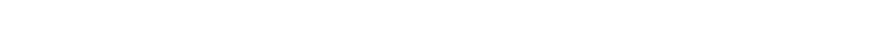
Frontiers in Psychology | Perception